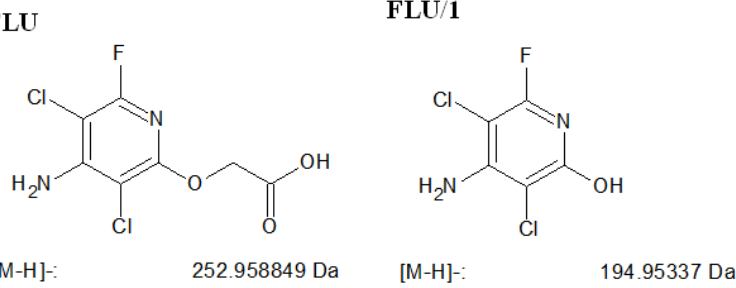
Figure 18. The structure of FLU, and the suggested structure and calculated mass of the formed ion of their detected stable product.